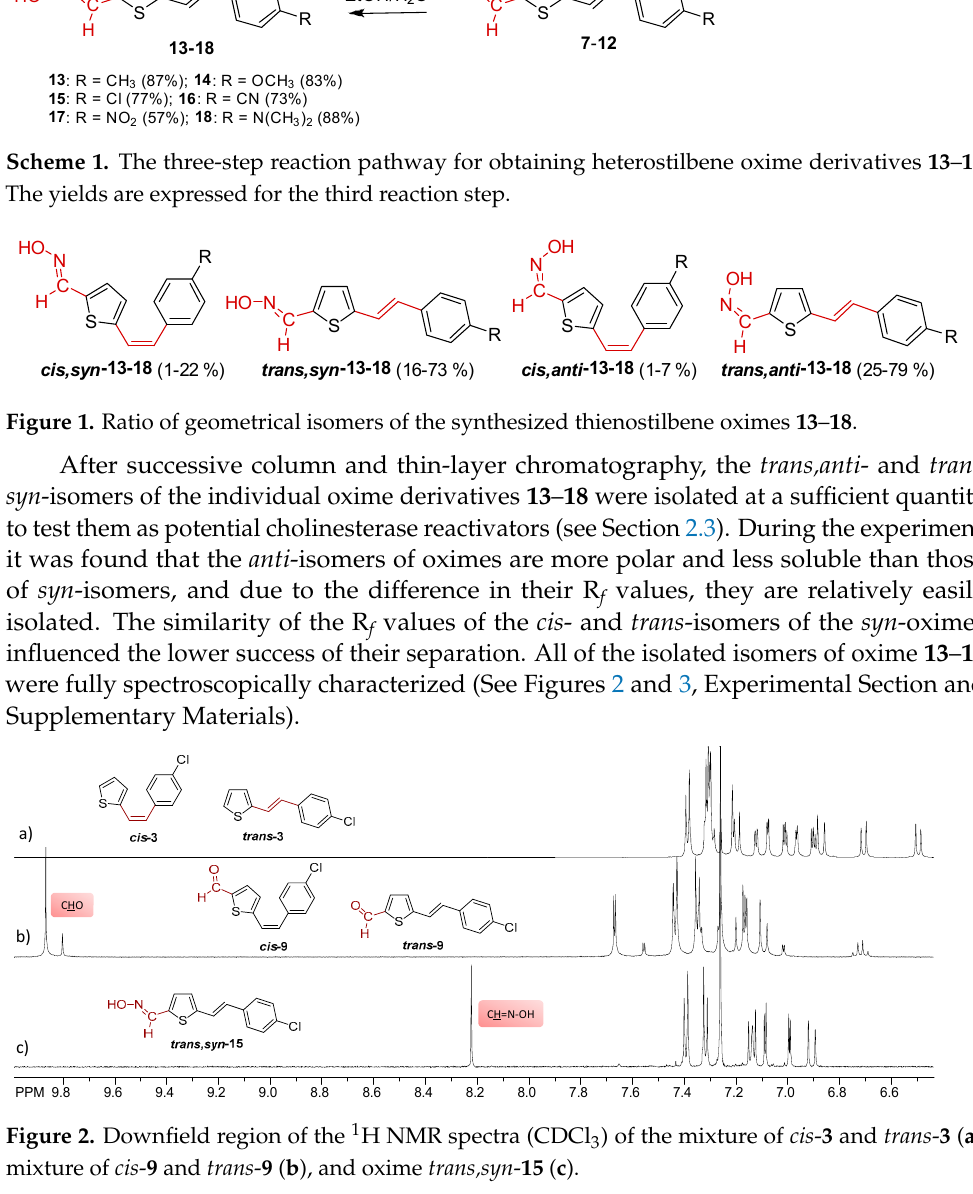
and trans -isomers of thienostilbene 1 – 6 as well as the ci s- and tran s-isomers of the formyla- (See Experimental Section and Supplementary materials).